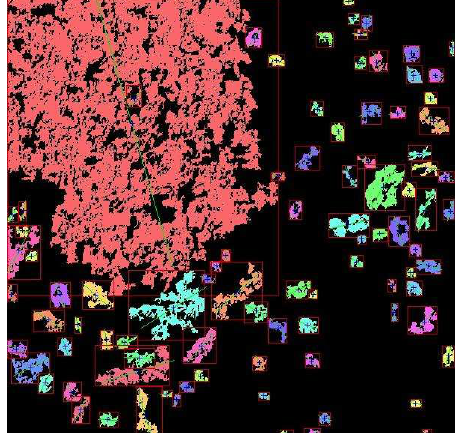
Figure 6: Results from the tree detection